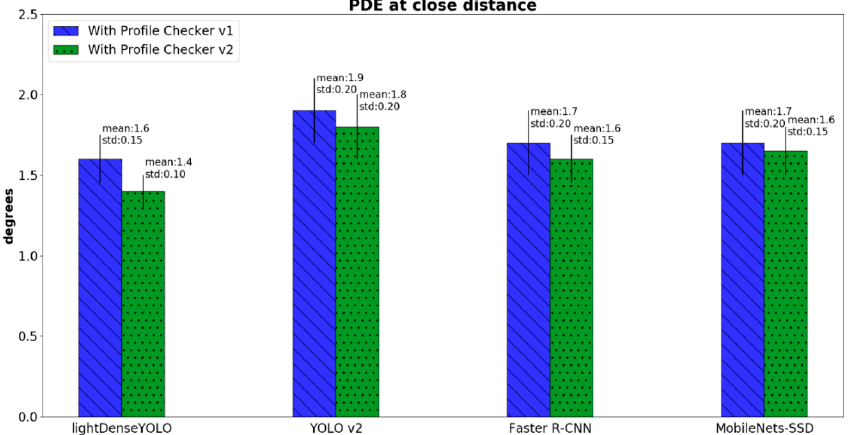
Figure 20. Comparison of predicted direction error (PDE) close distance images of various methods.